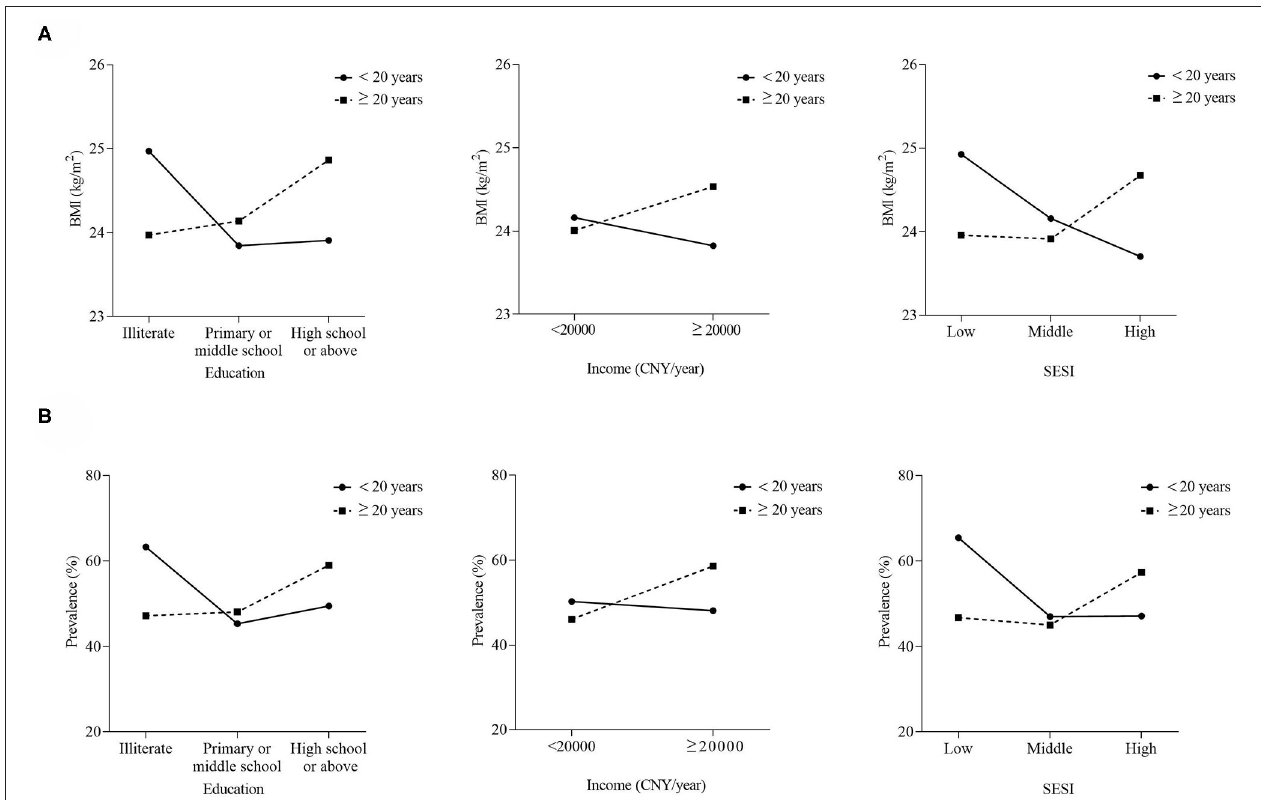
FIGURE 2 | Trends of BMI (A) and overweight/obesity prevalence (B) with socioeconomic status by age at arrival. BMI was adjusted for age, gender, smoking, drinking, occupational physical activity, leisure-time exercise, and length of residence; prevalence was age and sex